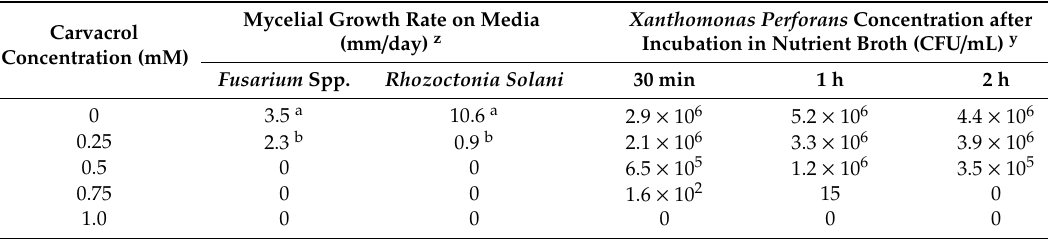
Table 2. E ff ect of carvacrol on pathogenic fungi and bacteria in